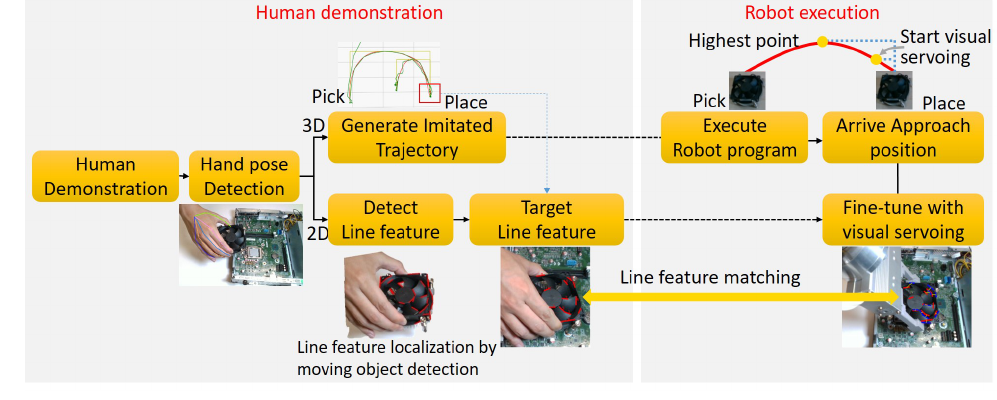
Figure 2. The pipeline of the proposed approach.